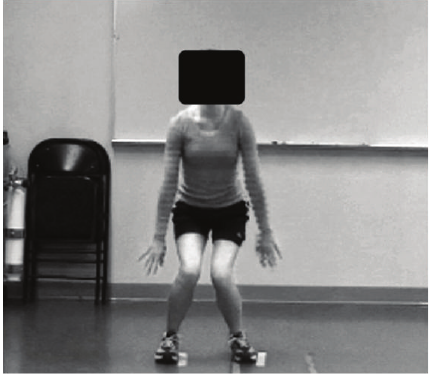
Figure 2: Lower extremity valgus at